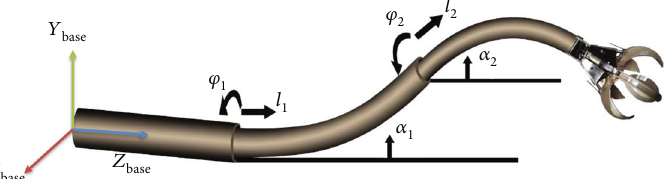
Figure 1: The scheme of a concentric tube robot comprising three precurved